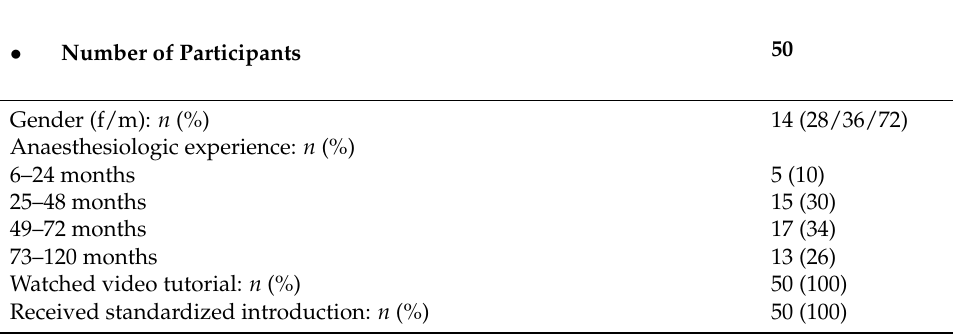
Table 1. Baseline characteristics of